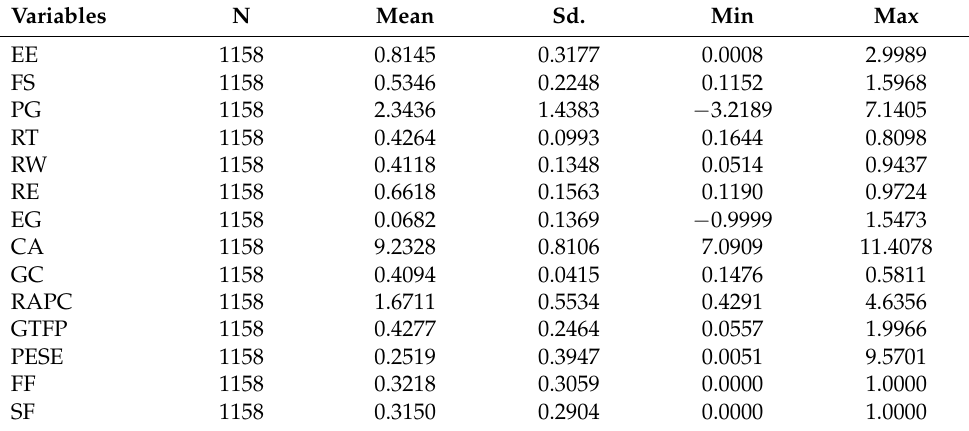
Table 2. Descriptive Statistics for